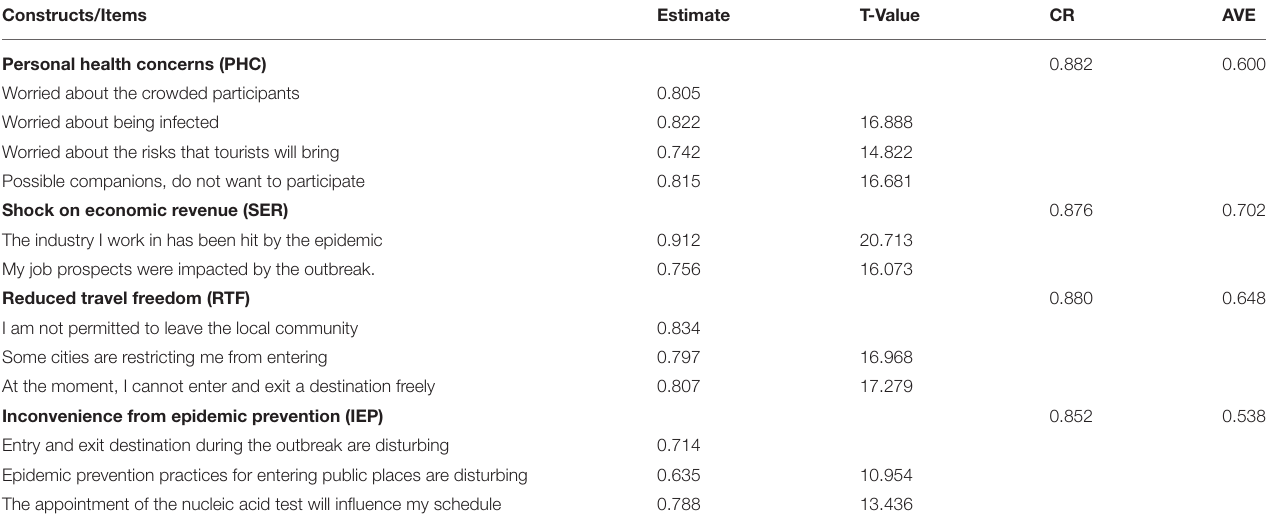
TABLE 3 | Results of the CFA ( n =